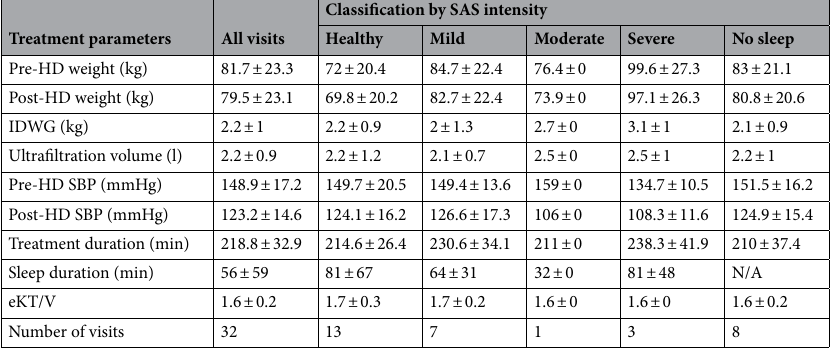
Table 1. Summary of dialysis treatments parameters (mean ± SD).